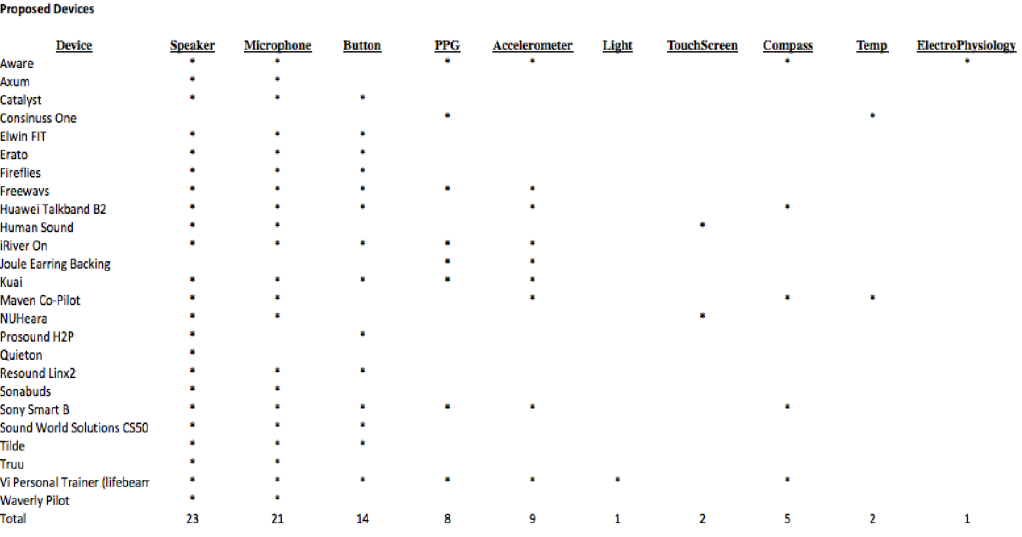
Figure 3. List of proposed hearables devices, and their associated features.